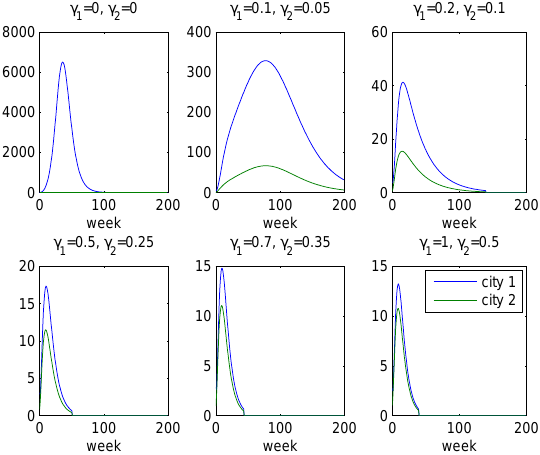
Fig. 3. Simulation of the evolution of the infected population per week for different values of Γ